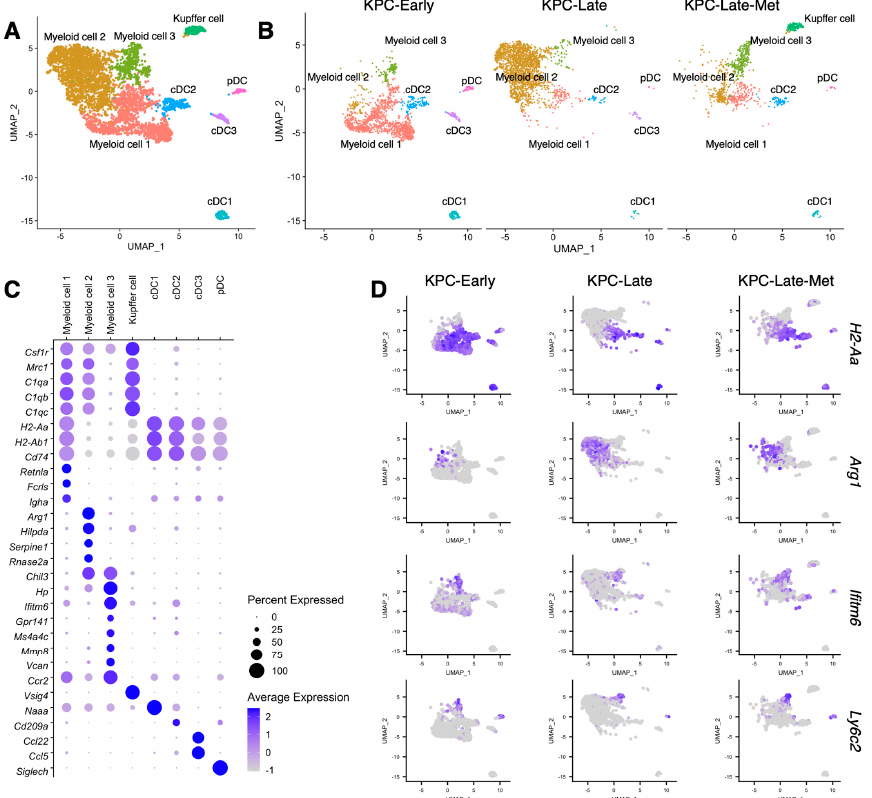
Figure 7. Distinct compositions of myeloid cells and dendritic cells in liver metastases. ( A – C ) Myeloid cells and dendritic cells (DCs) from primary tumors and liver metastases are characterized in UMAP plot ( A ) and compared across KPC-Early, KPC-Late, and KPC-Late-Met groups ( B ). The signature genes of myeloid cells and DCs in primary tumors and liver metastases are shown in dot plot ( C ). ( D ) The expression profiles of indicated signature genes of myeloid cell subpopulations in primary tumors and liver metastases are shown in UMAP